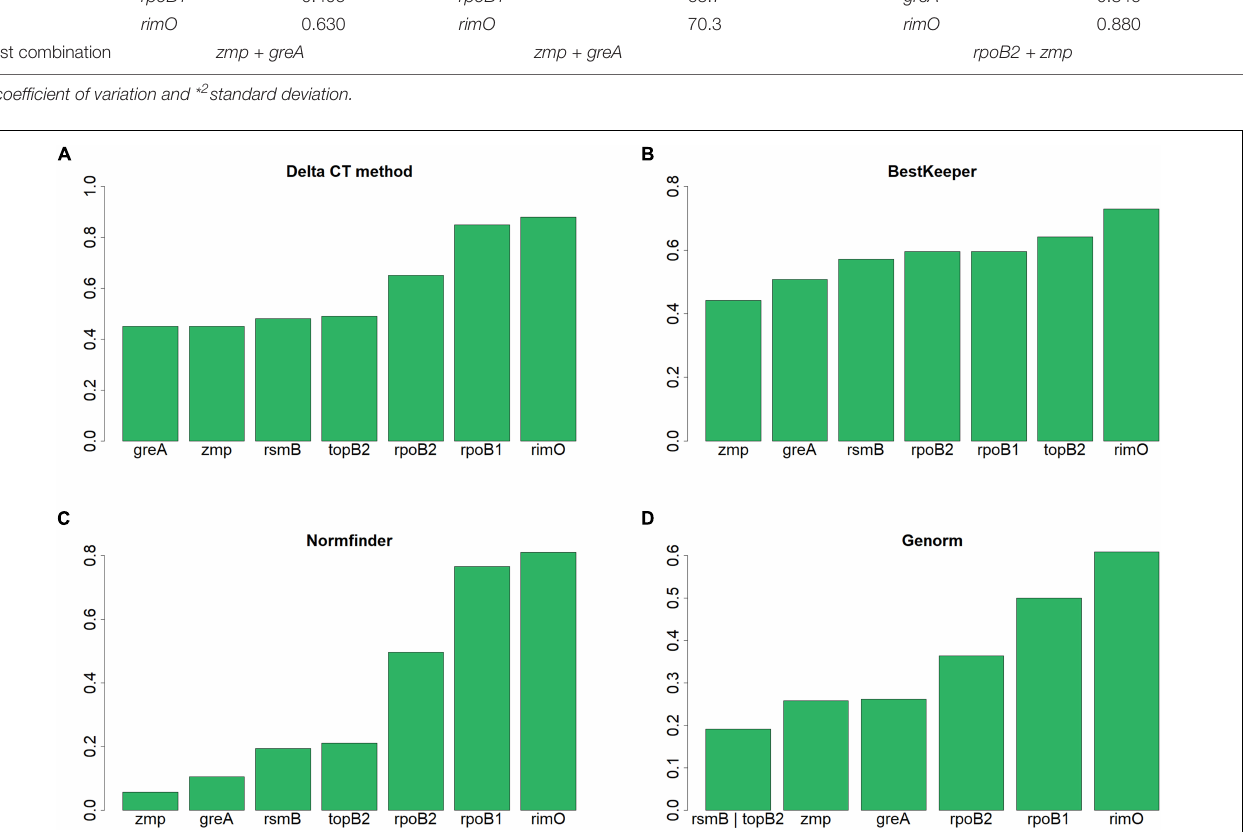
stress in the case of Staphylococcus aureus (Kyuma et al.,